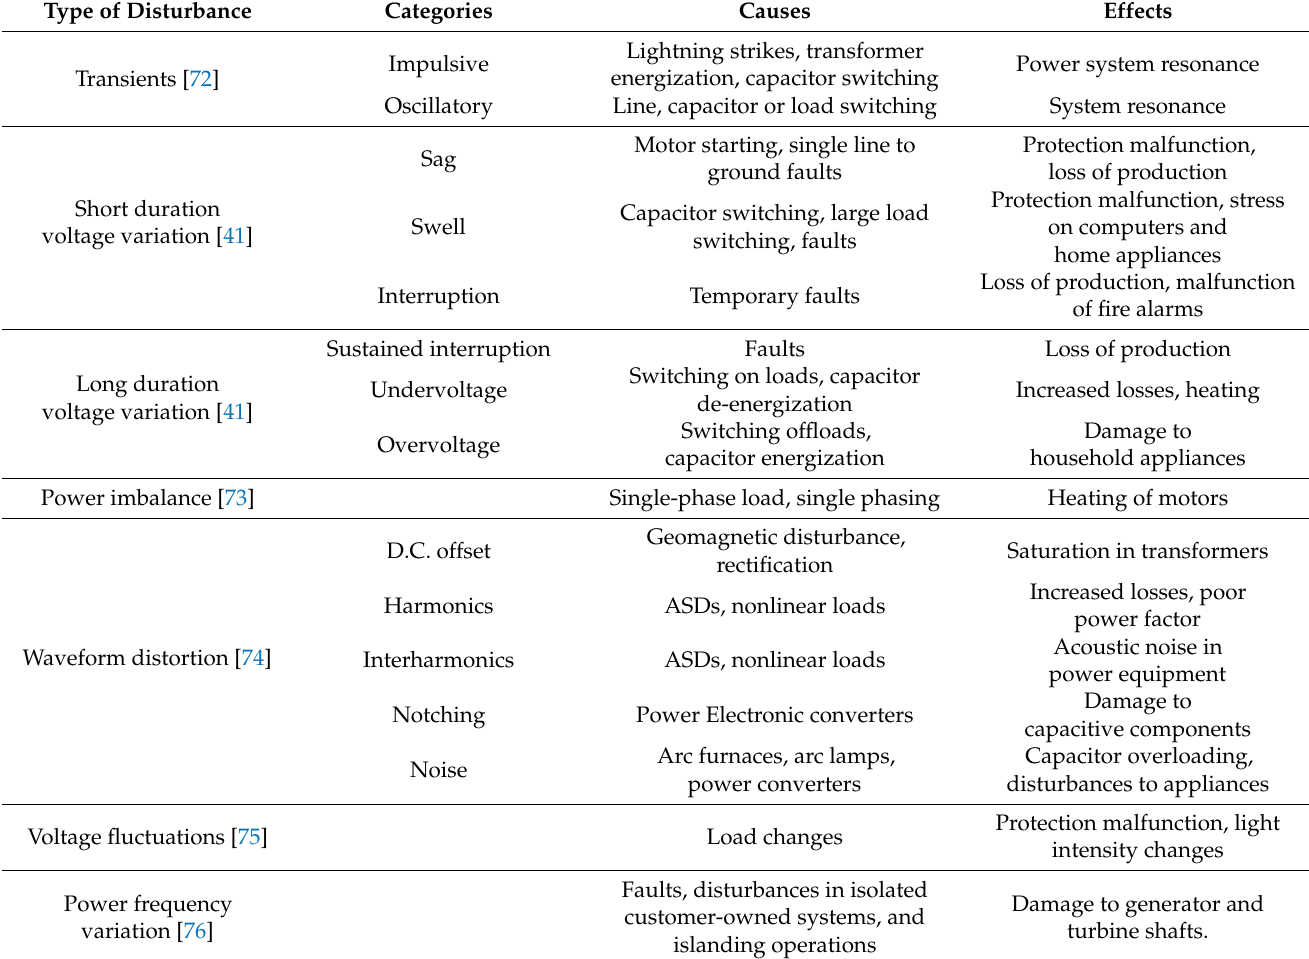
Table 3. PQDs and their causes and